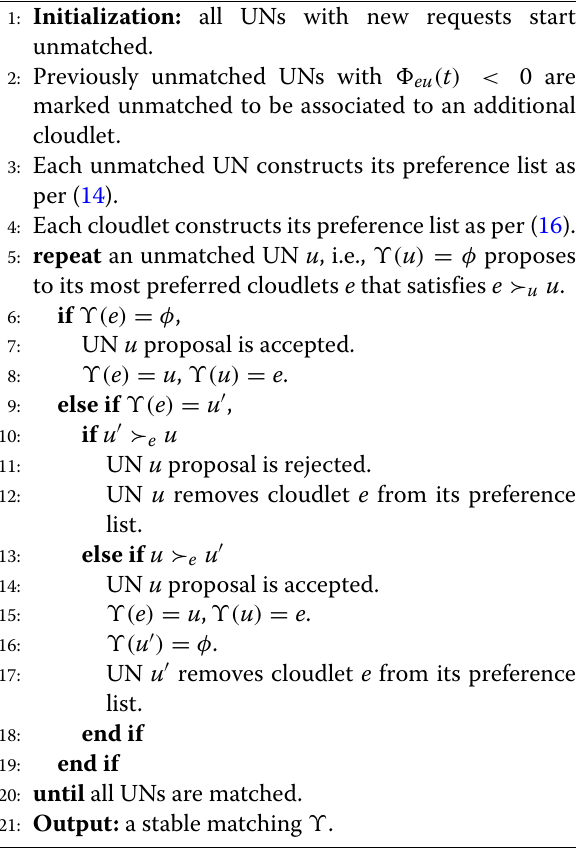
Algorithm 3 The DA algorithm for UN-cloudlet